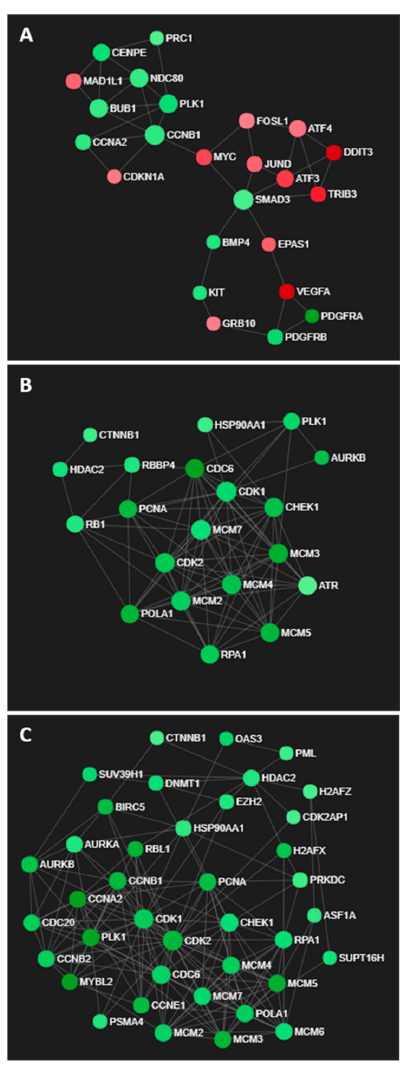
Figure 7. Transcriptomic networks induced by LXR-623 treatment. ( A ) Interconnected network of ER stress- and cell cycle-related genes in LXR-623-treated U373 cells. ( B , C ) Networks of downregulated genes associated with cell cycle regulation in LXR-623-treated KNS42 and SF188 cells,